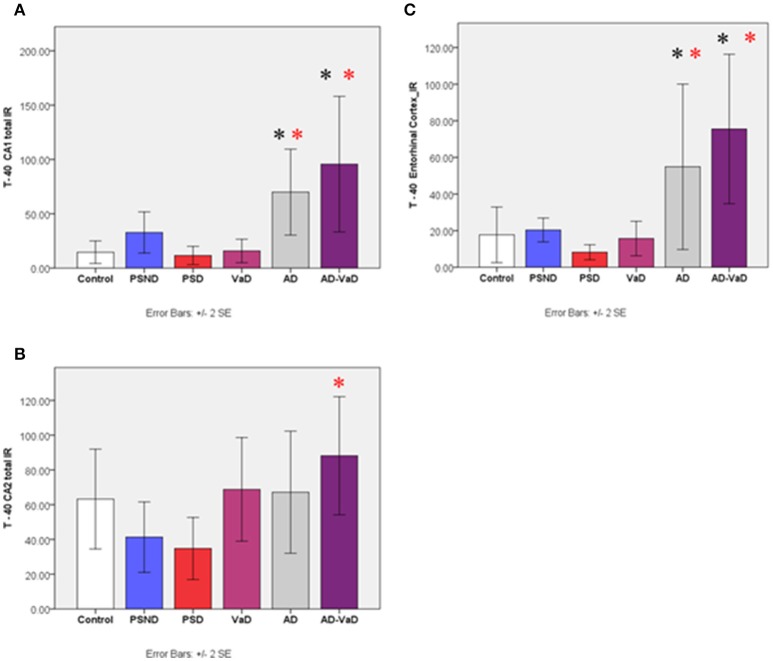
Bar graphs showing the distribution of Aβ-40 IR across hippocampal sub-regions (A) CA1, (B) CA2, (C) Entorbinal cortex in Controls, PSND, PSD, AD, VaD and AD_VaD. Bars show ± 2 SEM *Mann Whitney U–test was used to compare means of each group. *p < 0.05; + p < 0.1 (in comparison with the control group). *(red) showed significant difference from PSD group. lR (immunoreactivity).